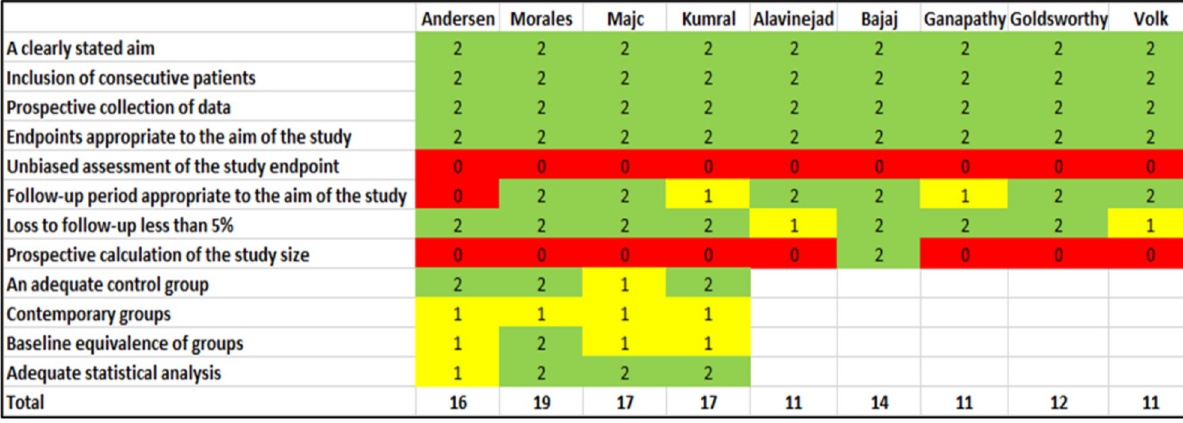
Fig 3. Bias assessment of the non-randomized studies. Guided by Methodological Index for Non-Randomized Studies.